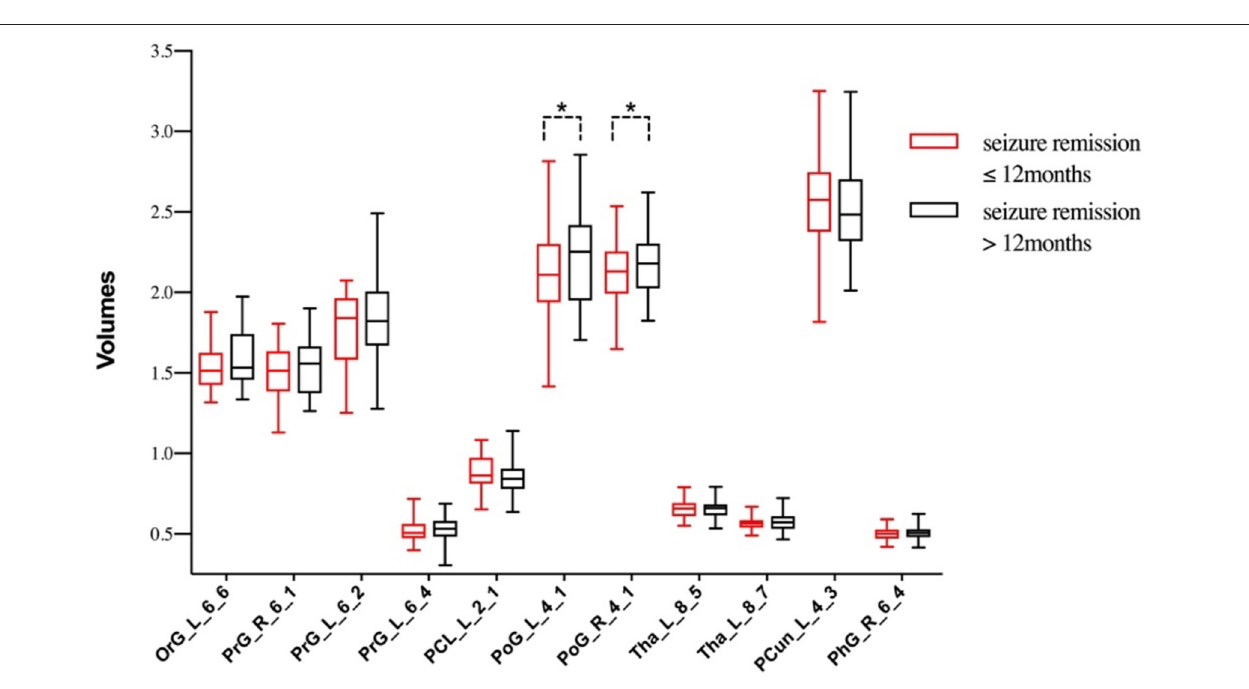
FIGURE 3 | The differences of gray matter volumes between patients with different seizure remission time. * P < 0.05, TIV, age and duration as